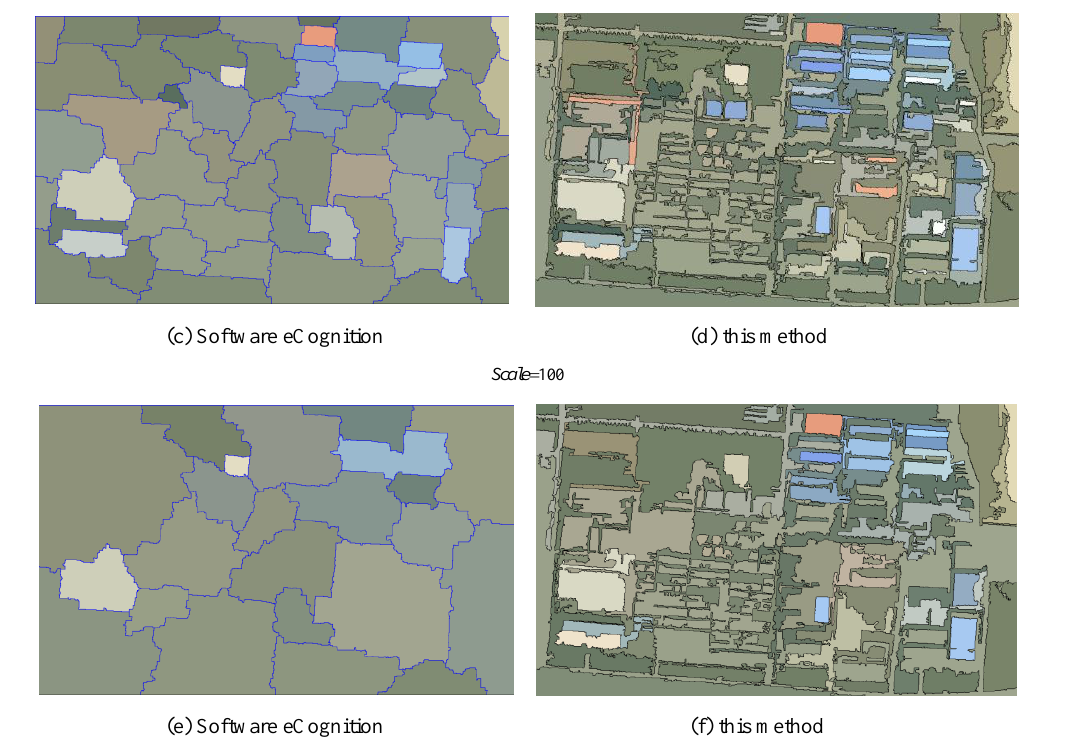
Figure 6. Segmentation results of the ZY-3 satellite